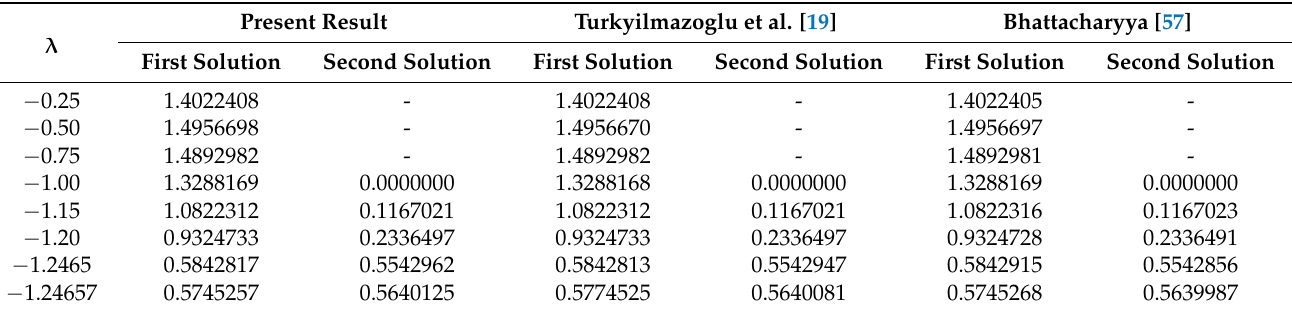
Table 3. Approximation values of Re x 1/2 C f by certain values of λ when ε = M = δ = S = φ 1 = φ 2 =